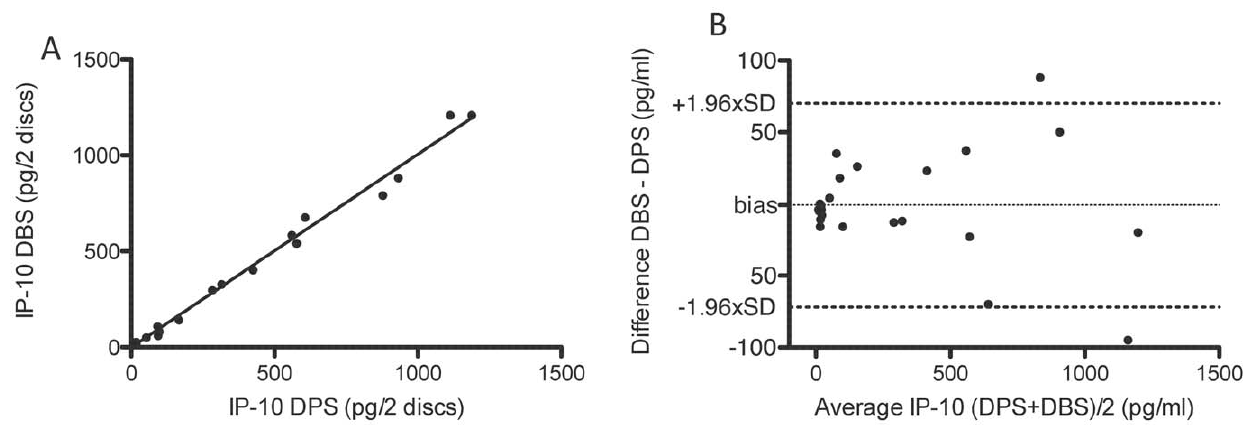
Figure 4. IP-10 responses in DBS compared to DPS. QFT-CMV test stimulated blood from 8 healthy individuals, 5 CMV responders, were used to compare IP-10 signals in DBS and DPS samples. Nil antigen and mitogen samples pooled (n=24). Figure 4A. Correlation analysis, (p , 0.0001, Spearman); Figure 4B Bland-Altman plot of the same data. Each sample is represented on the graph as the average of the two measurements against the difference. The limits of agreement are specified as the average difference (bias, 2 0.8 pg/ml) 6 1.96 standard deviation of the difference, (71 pg/